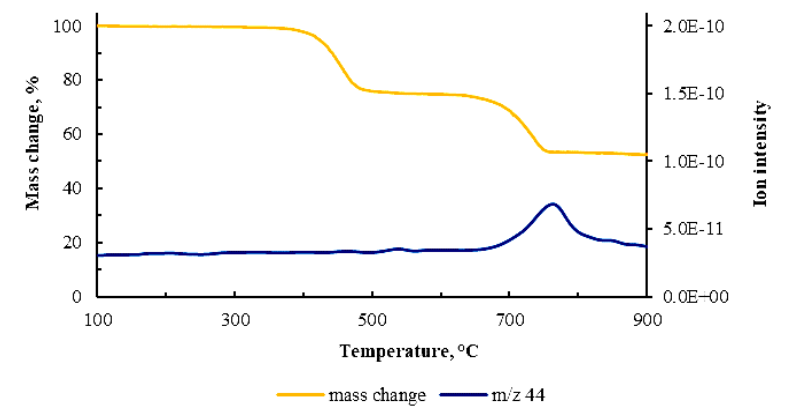
Fig. 2. Decomposition of oil shale and evolution of CO 2 in N 2